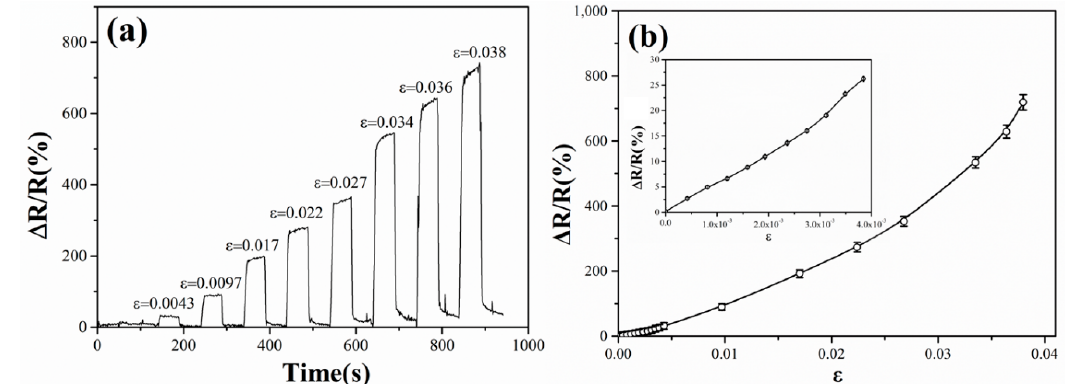
Figure 8. ( a ) Electrical resistance response curve of the strain sensor under pull-and-release cycles. ( b ) Relative resistance changes as a function of the applied strains. The insert illustrates the response behavior to very small strains generated by subjecting the PET membrane to bending cycles.